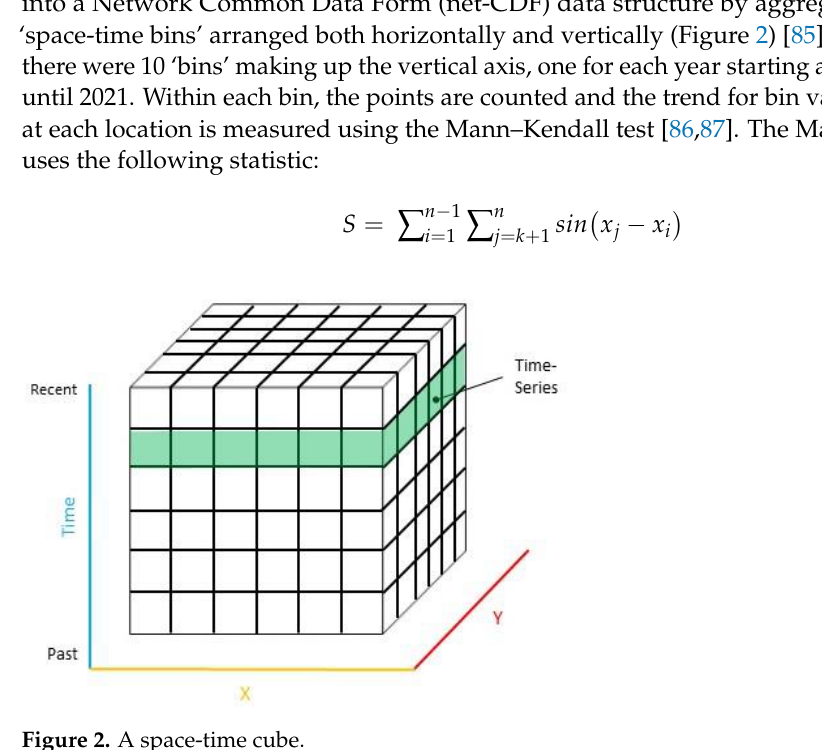
Figure 2. A space-time cube.